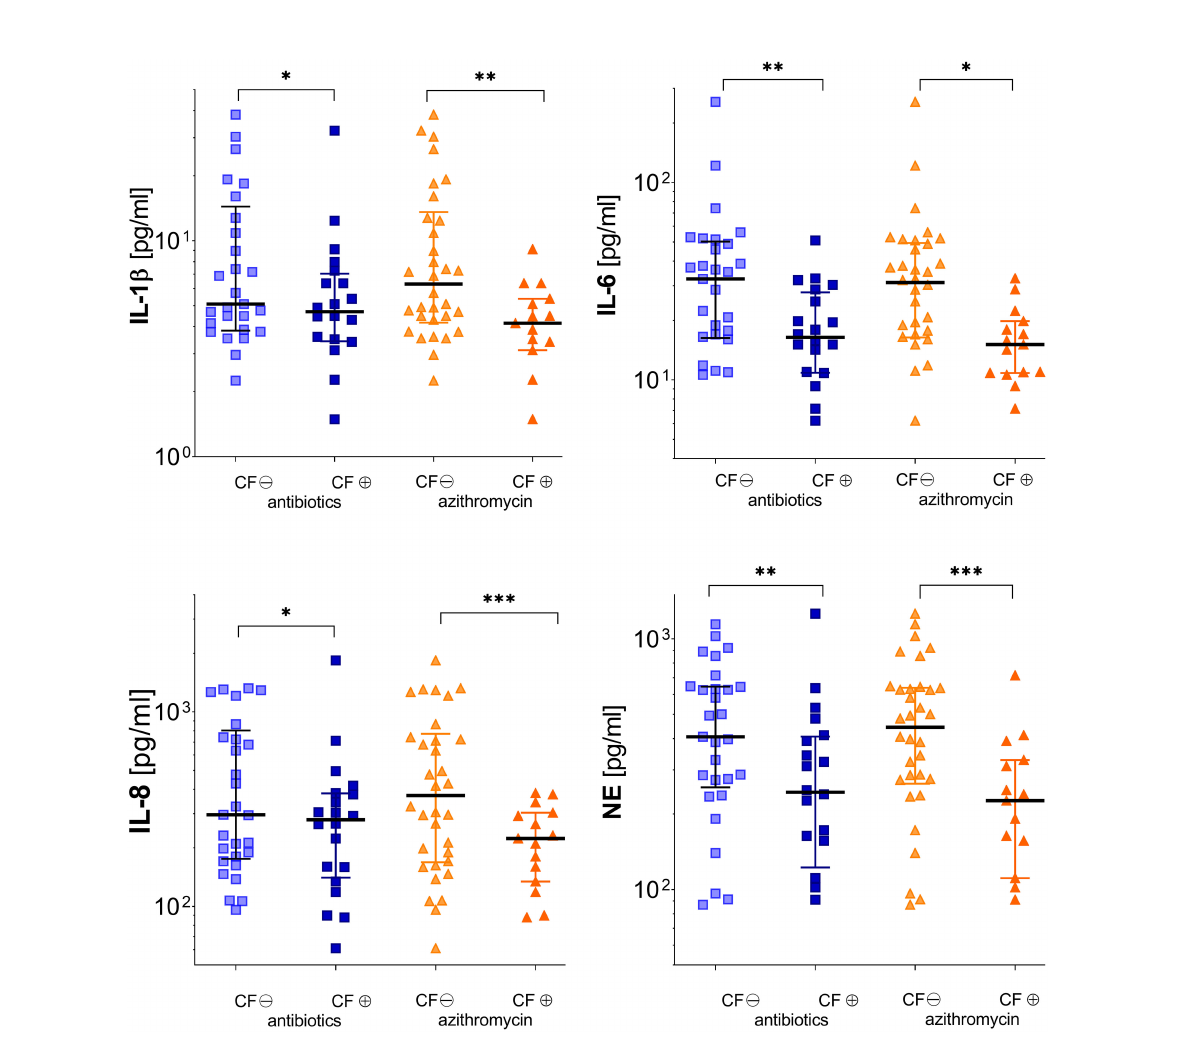
FIGURE 4 In fl ammatory markers in subgroups of patients according to either receiving ( ⊕ ) or not receiving ( ⊖ ) pulmonary inhaled antibiotics (tobramycin, colistin, and aztreonam) or oral azithromycin (see Tables 2, 3). Signi fi cance levels are displayed as follows: *p <0.05; **p<0.01; ***p